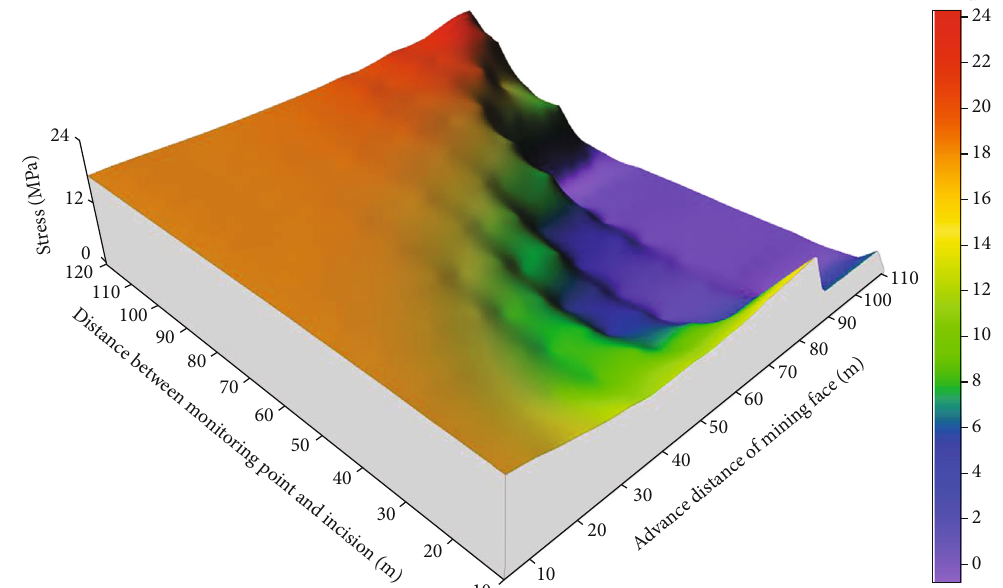
Figure 13: Vertical stress of the extra-thick conglomerate.